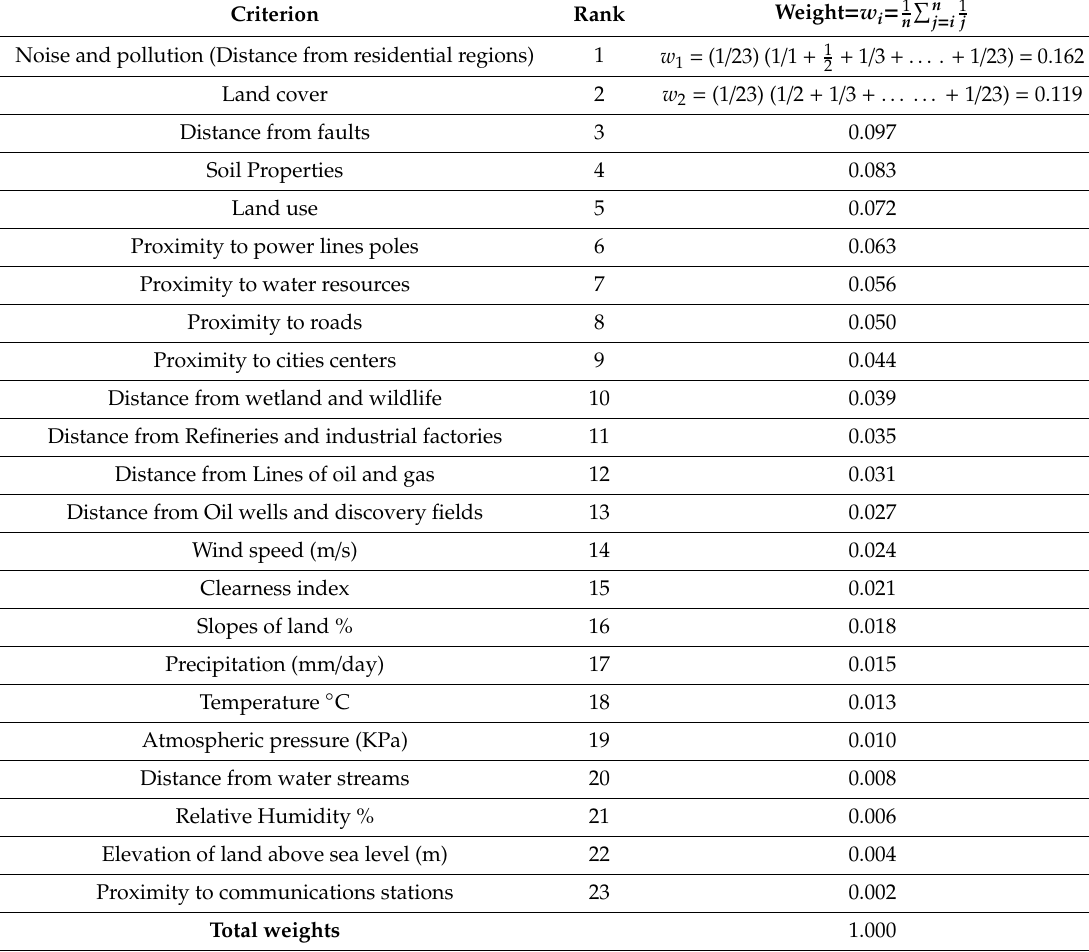
Table 14. Weights of criteria and sub-criteria using the ROC